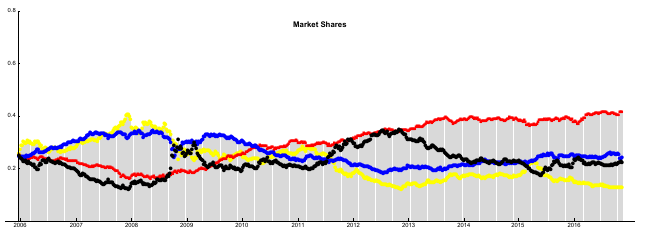
Figure 1. Market shares of WTI, SOLAR, WIND, and TECH across time. WTI has a different scale from SOLAR, WIND, and TECH. Therefore, in this figure we add 1000 to the WTI to avoid it collapsing on the x